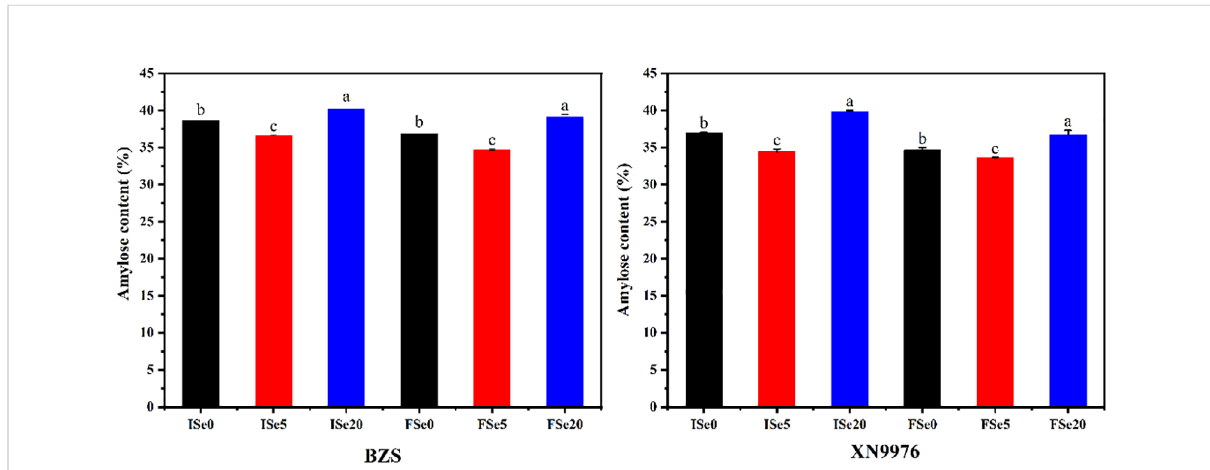
FIGURE 1 The effects of different selenium treatment levels on the amylose content of common